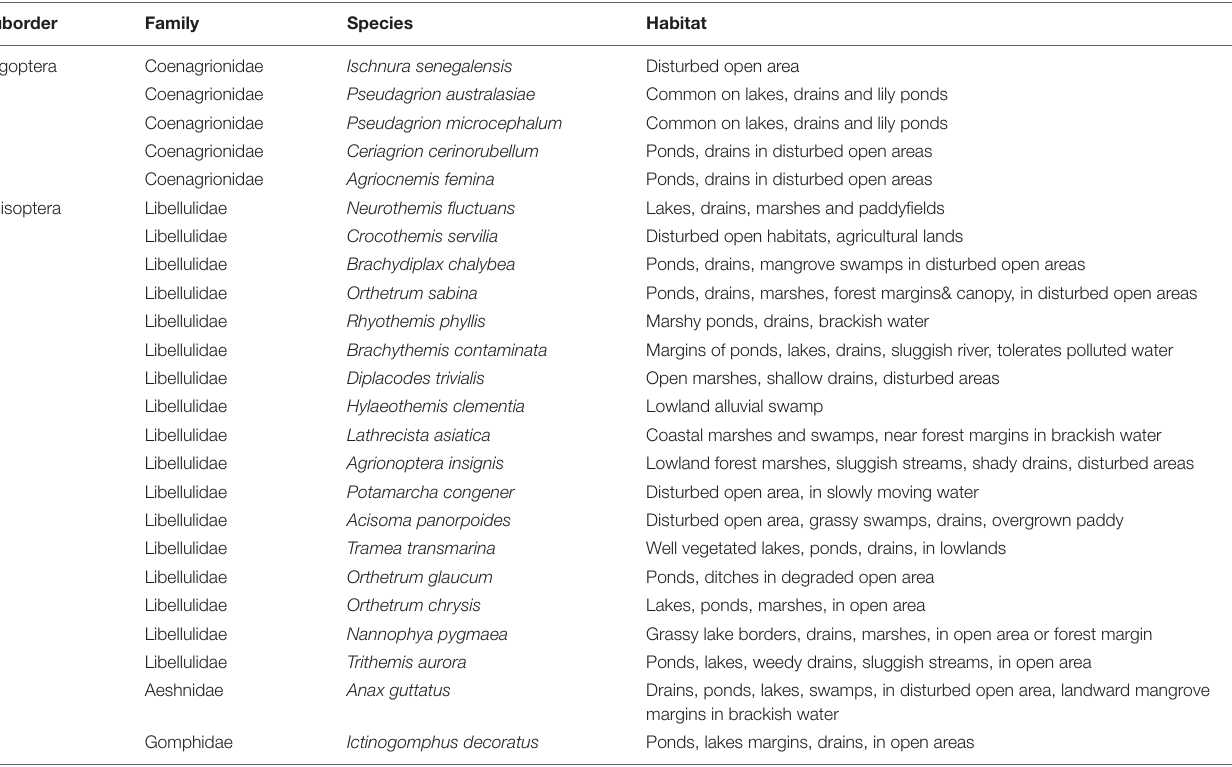
TABLE 2 | Species list of principal Odonata recorded at the study sites.